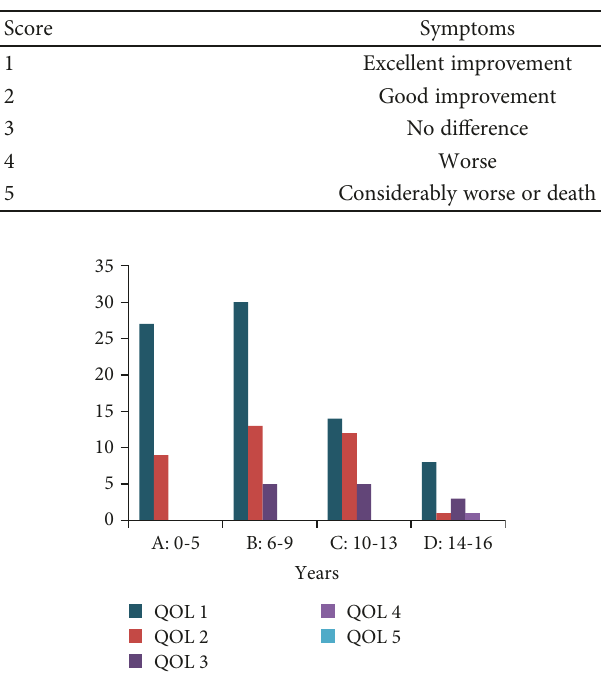
Table 4: Quality of life (QOL) score.